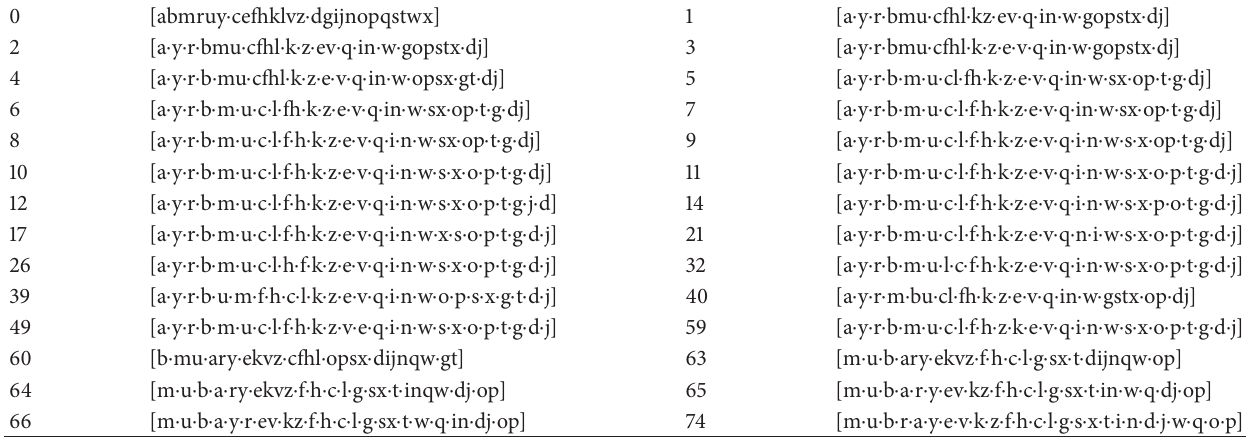
Table 1: Partitions at significant nodes of the search tree of Figure 2.